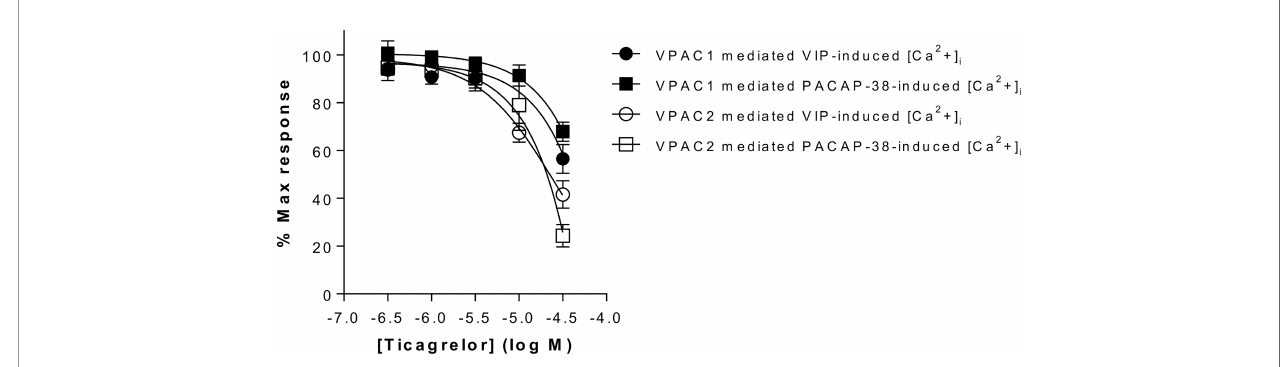
FIGURE 3 | Impact of ticagrelor on VPAC1 and VPAC2 receptors. Inhibition of VPAC1 and VPAC2 activity by ticagrelor was assessed in an aequorin-based calcium-mobilization assay. The response of CHO cells expressing VPAC1 to 3 nM VIP or 10 nM PACAP-38 and of CHO cells expressing VPAC2 to 10 nM VIP or 30 nM PACAP-38 was tested in the presence of increasing concentrations of ticagrelor. Results are the mean ± SEM of at least three independent experiments performed